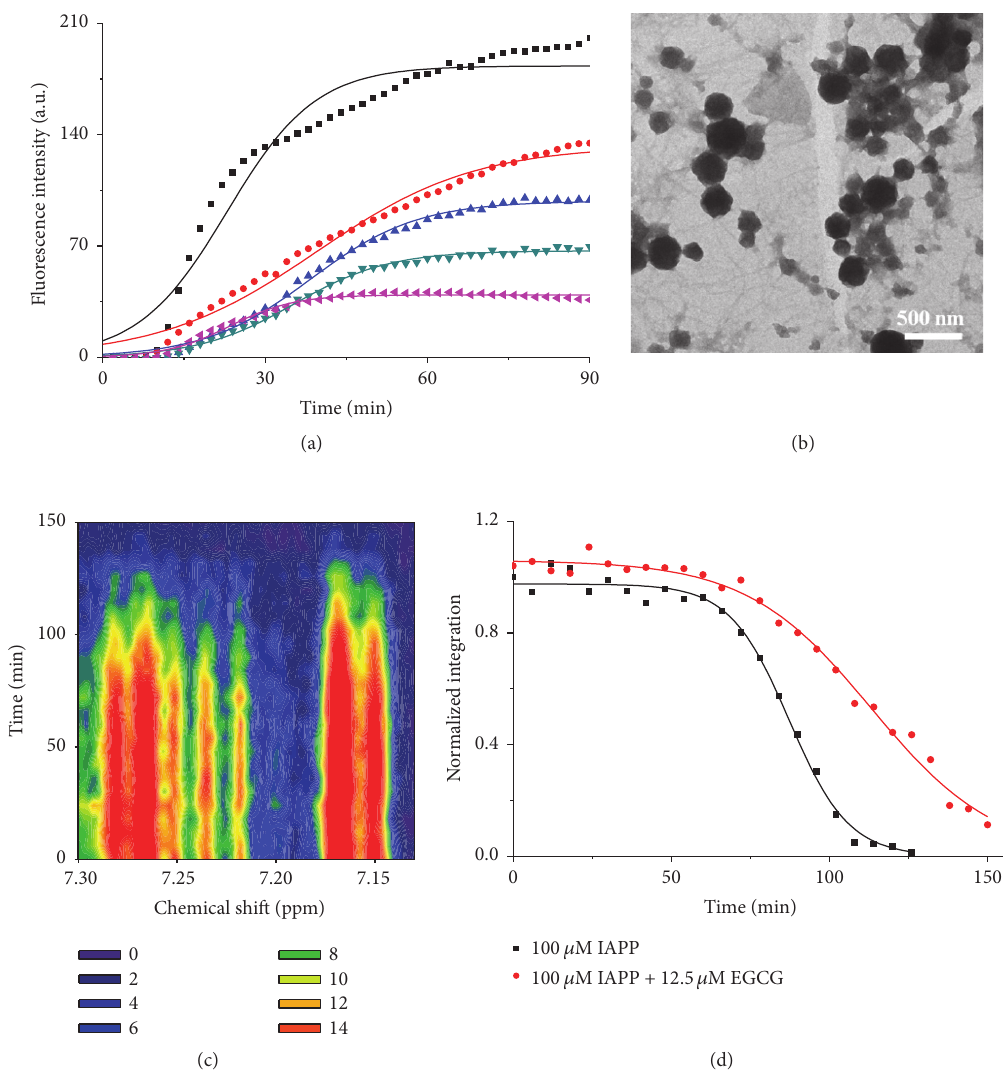
Figure 7: The influenceof EGCG on the fibrillation and aggregation of hIAPP. (a) Kinetics of 16 𝜇 M hIAPP fibrillation with 0 ( ◼ ), 2 ( e ), 8 ( 󳵳 ), 16 ( 󳶃 ), and 32 ( 󳶣 ) 𝜇 M EGCG in 20 mM PBS at pH 7.4 under 37 ∘ C monitored by ThT fluorescence. The values represent mean ( 𝑛 = 3 ). Solid linesrepresentthe curvesfitted using (1). (b) TEM image of 16 𝜇 M hIAPP incubatedin 20mM PBS with 2 𝜇 M EGCG for 2h. (c) Contourplots of 1 H NMR spectra within chemical shift from 7.13 to 7.3ppm for 100 𝜇 M hIAPP incubated in 6mM PBS at pH 7.4 and 25 ∘ C on incubation time with 12.5 𝜇 M EGCG. (b) Aggregation kinetics of integratedresonanceintensity of 1 H NMR spectrafrom 7.13 to 7.3ppm of 100 𝜇 M hIAPP without ( ◼ ) and with ( e ) 12.5 𝜇 M EGCG. Solid lines represent the curves fitted using (1). The integrationvalues were normalized to the initial hIAPP alone